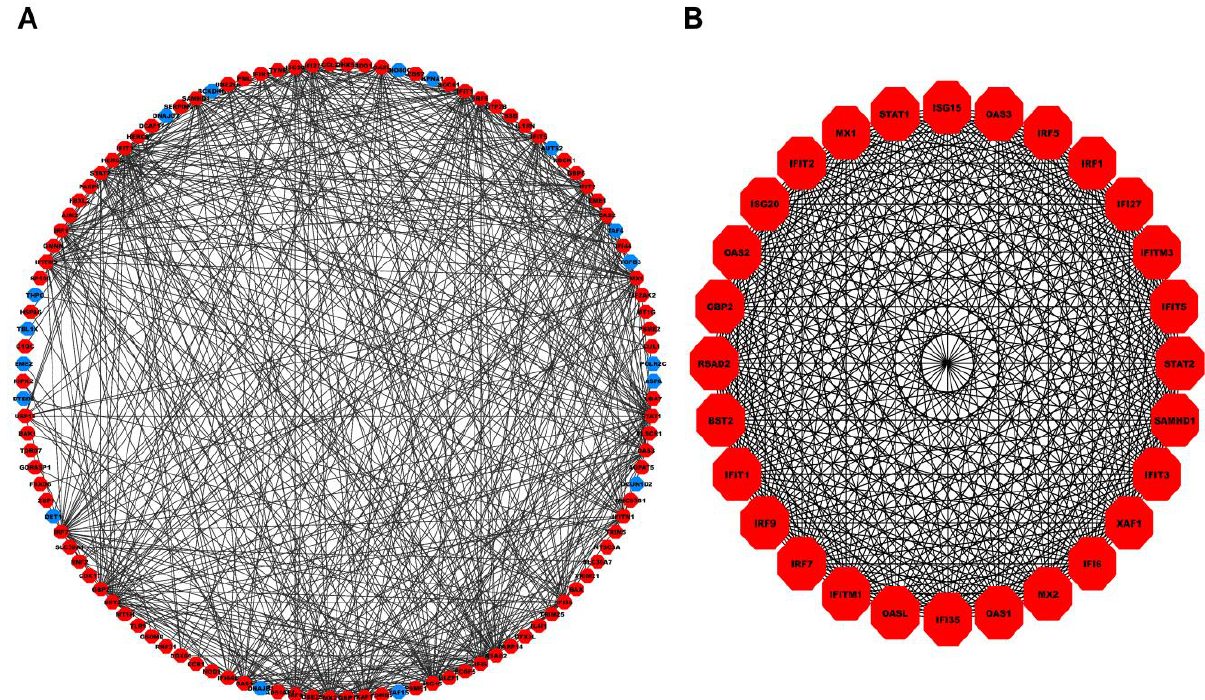
Figure 4. ( A ) PPI network comprising 114 nodes and 545 interaction edges constructed using the STRING database corresponding to interaction score > 0.9. The red- and blue-colored nodes signify up and downregulated proteins. ( B ) Top scoring PPI module comprises 28 nodes and 374 edges. PPI, Protein-Protein Interaction.